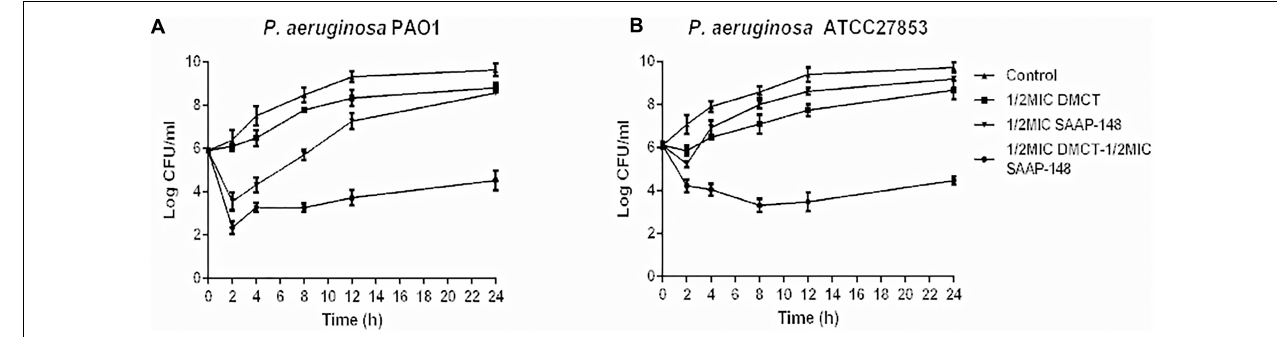
FIGURE 3 | Time-kill curves for DMCT and SAAP-148 alone or combination against P. aeruginosa . Time-kill assay using one-second the MIC of each agent (6.25 µ M of DMCT, 3.125 µ M of SAAP-148) alone and in combination for PAO1 (A) and ATCC27853 (B) . The data were presented as mean ± SD.